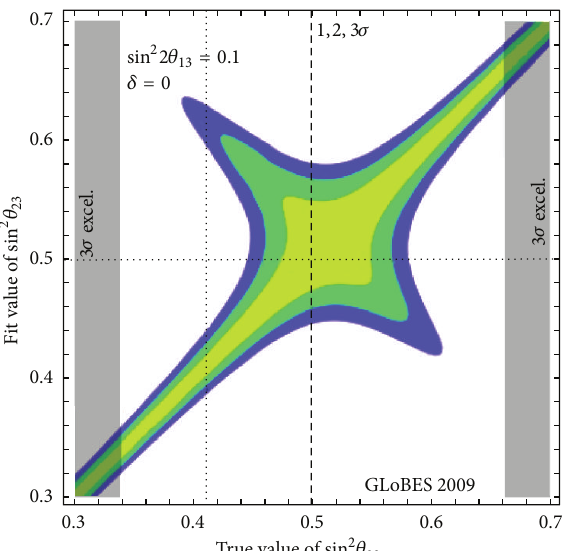
Figure 3: Determination of sin 2 𝜃 23 at 1, 2, 3𝜎 (1 dof) as a function of the true value from T2K, NOvA, and DayaBay with their final exposures according to Table 2. True values of sin 2 2𝜃 13 = 0.1 and 𝛿 = 0 have been assumed. The vertical dotted line and the shaded regions indicate the present best fit point and 3𝜎 excluded region, respectively. Figure is based on the results of